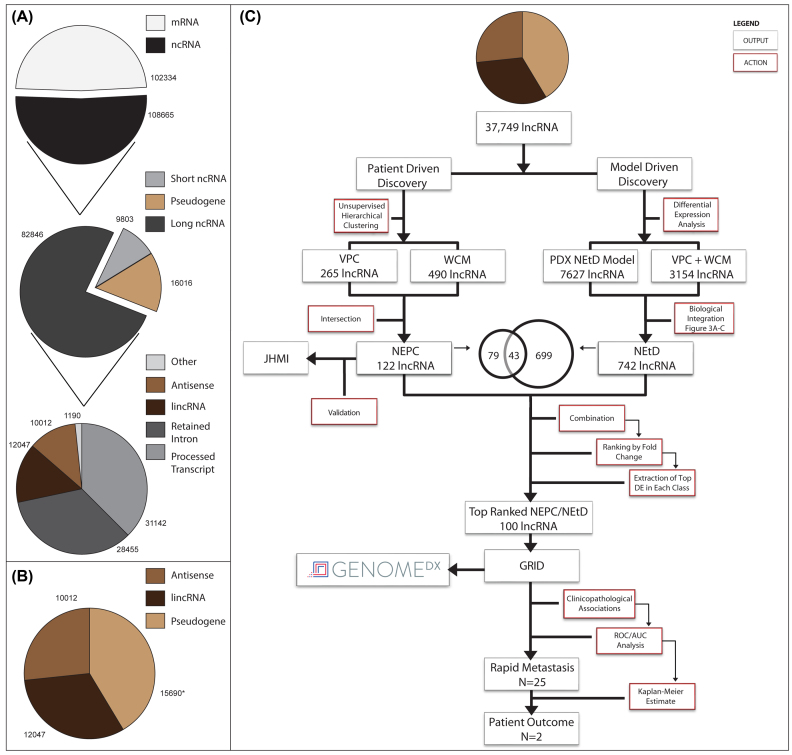
Transcriptome composition and study design. A) Proportions and totals of transcripts detected using our sequence analysis pipeline. Transcripts were separated into protein coding (mRNA) or non-coding RNA (ncRNA) and as defined by Ensembl's core biotypes as either mRNA, lncRNA, short ncRNA, or pseudogene. Within lncRNA, there exist seven classes, including processed transcripts, retained intron, lincRNA, antisense, sense intronic, sense overlapping, and three prime overlapping ncRNA (the last three labelled as “other”). Transcript totals are denoted around each pie slice. B) The three transcript classes used in this study due to their ability to separate AD and NEPC tumours, which collectively totalled 37,749 lncRNAs. *The pseudogene total was the combination of eight pseudogene subclasses and collectively referred to as pseudogene here. These subclasses include processed pseudogene, unprocessed pseudogene, transcribed unprocessed pseudogene, transcribed processed pseudogene, translated processed pseudogene, polymorphic pseudogene, unitary pseudogene, and pseudogene. These lncRNAs formed the basis for all down-stream analysis and C) the studies project workflow and study design. AUC, area under the curve; GRID, GenomeDx Decipher GRID database; JHSM, Johns Hopkins School of Medicine; PDX, patient derived xenograft; ROC, receiver-operating characteristic. See Table 2 for cohort clinical features and compositions.